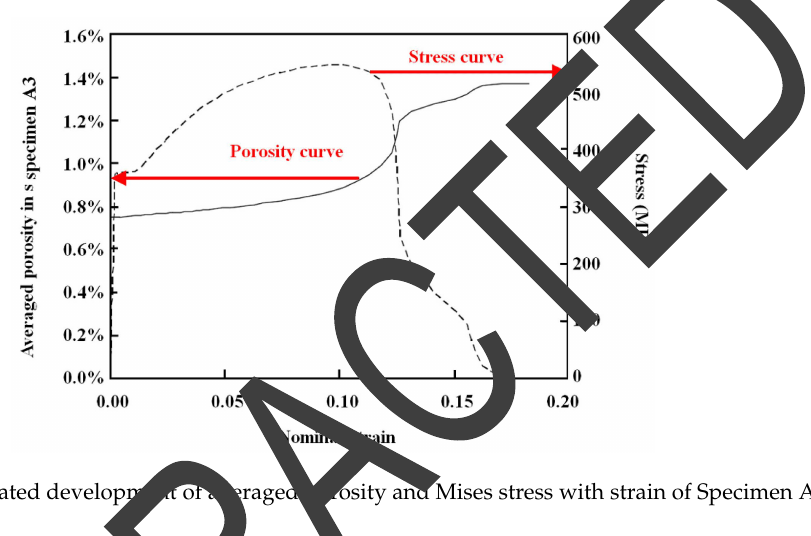
Figure 11. Simulated development of averaged porosity and Mises stress with strain of Specimen